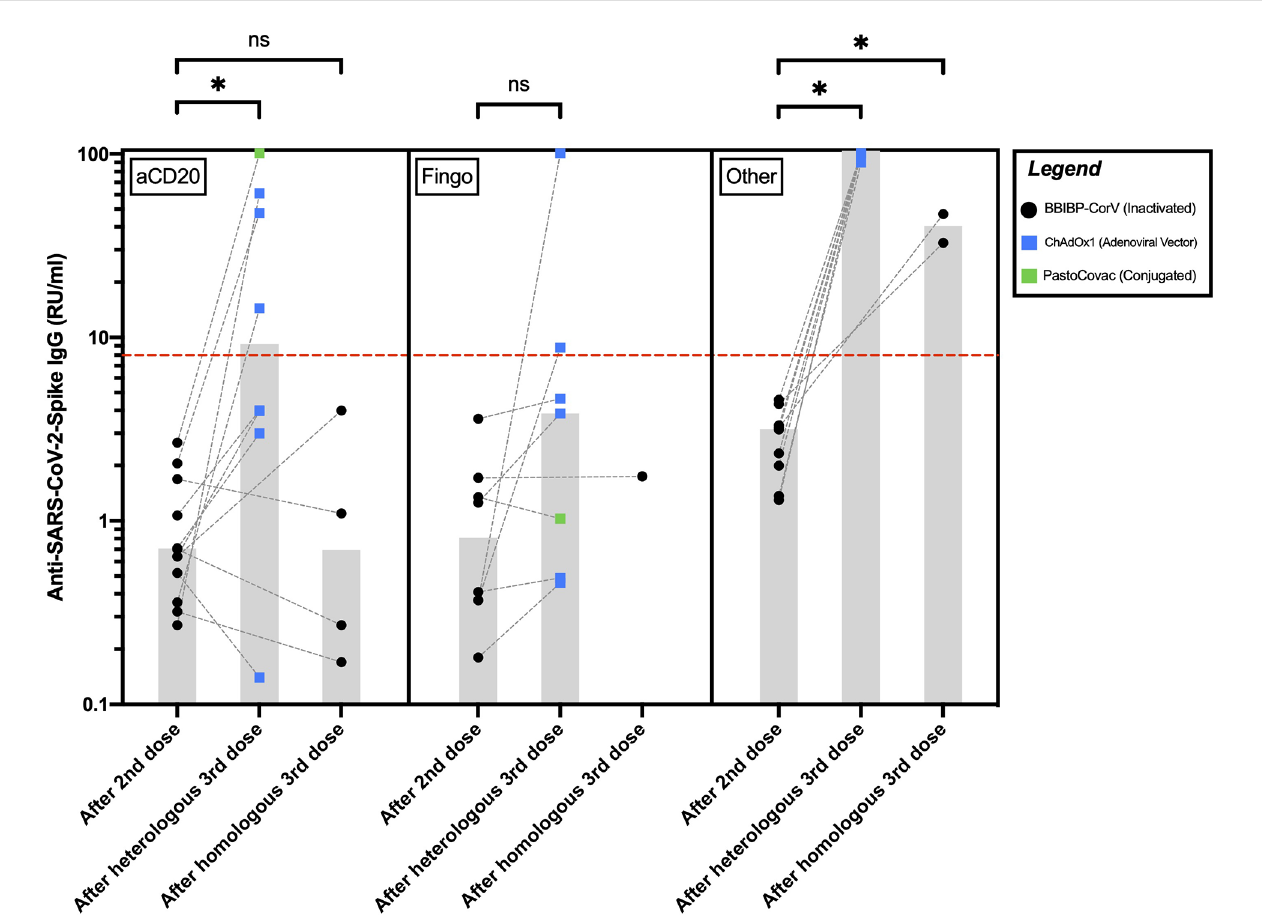
FIGURE 1 Anti-SARS-CoV-2-Spike IgG levels in pwMS receiving anti-CD20 therapies, fi ngolimod, or other disease-modifying therapies after their second and third COVID-19 vaccine doses. The red hyphenated line corresponds to the seropositivity cut-off index. The gray bars correspond to the median of IgG levels. *P <0.05; ns, P >0.05. aCD20, anti-CD20 therapies; Fingo, fi ngolimod; RU/ml, relative units per milliliter.